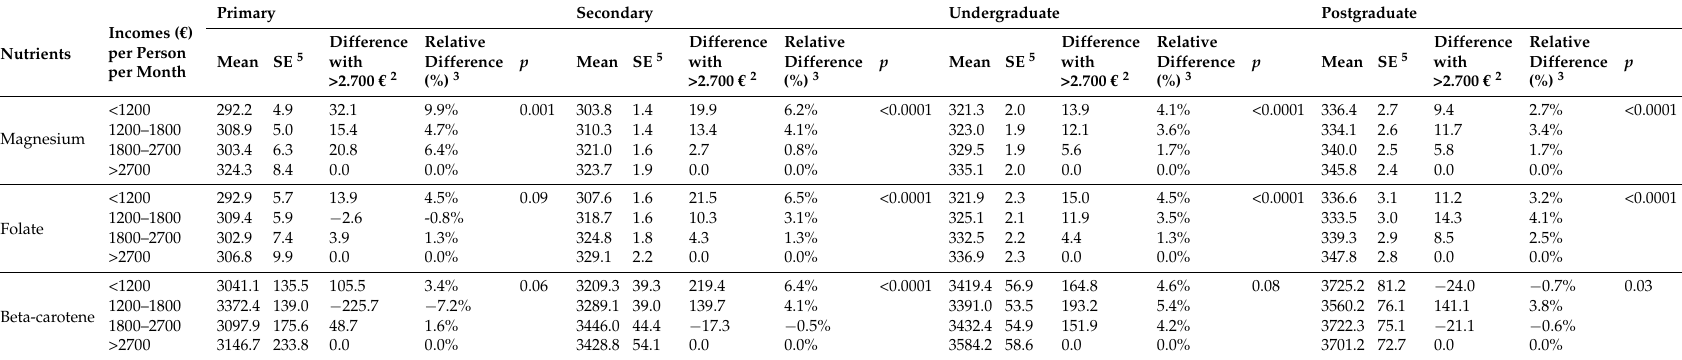
Table 4. Associations between dietary intake of magnesium, folate and beta-carotene and income stratified by educational level in women ( N = 72,154) 1,4 .